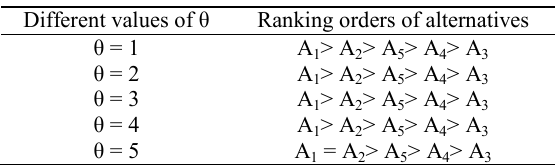
Table 7. Ranking orders of alternatives with different values of θ Different values of θ Ranking orders of alternatives